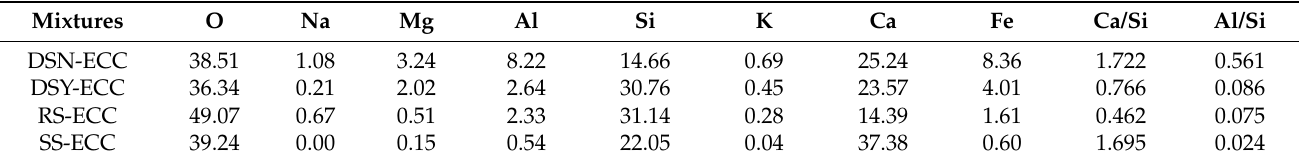
Table 5. Elemental composition and content of different fine aggregates at the junction with the matrix